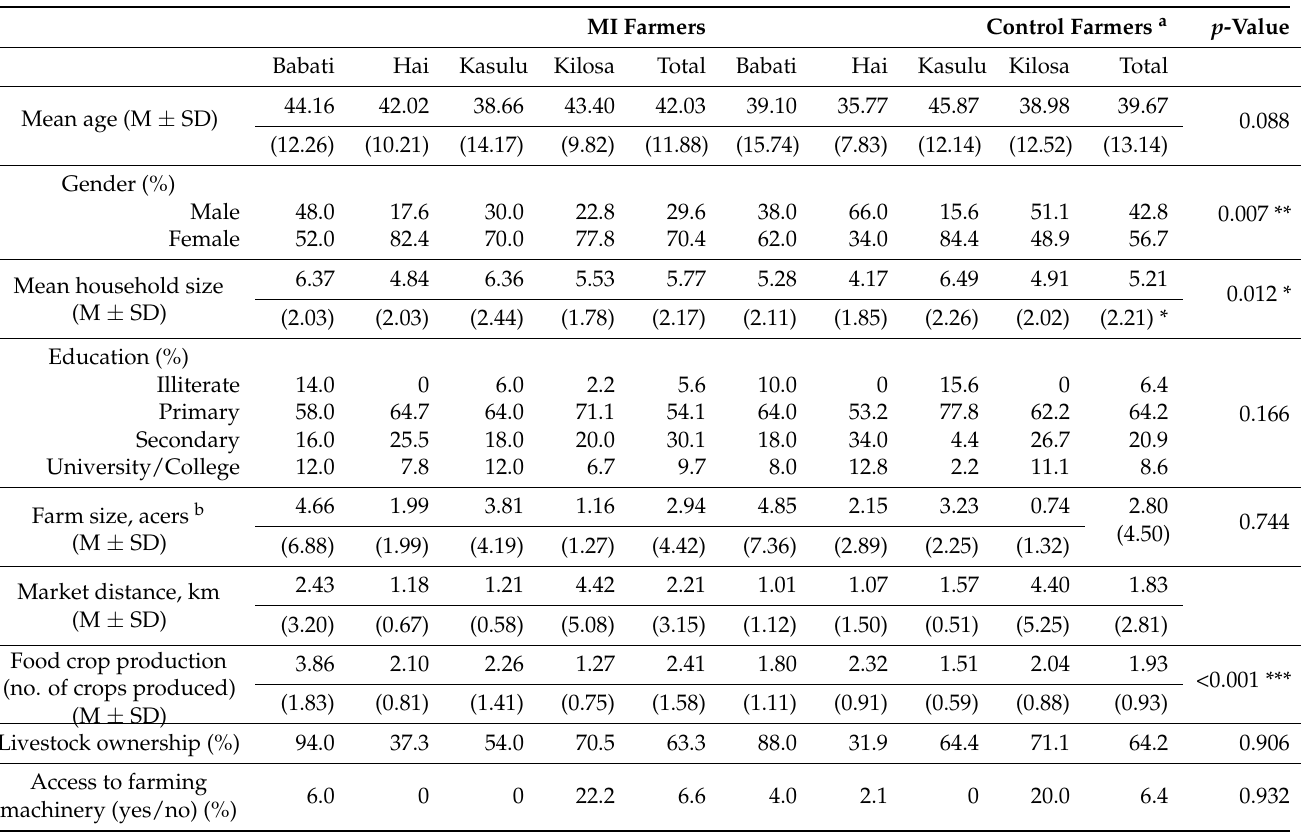
Table 2. Demographic, socioeconomic, and farm characteristics of the MI farmers and the control farmers in the different study